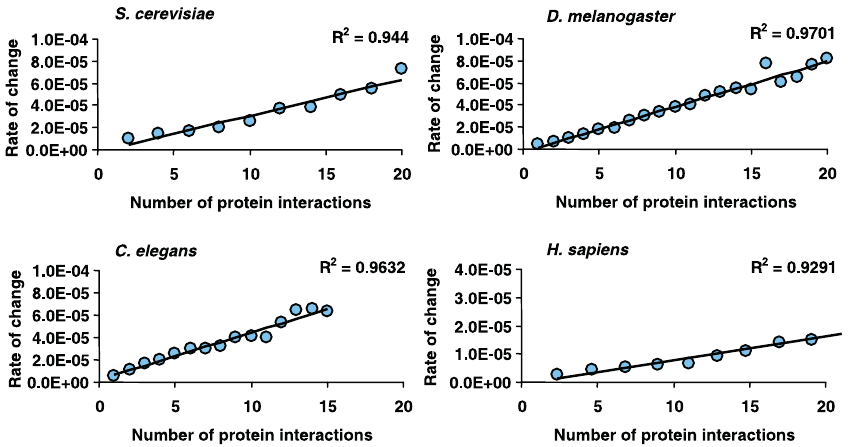
Figure 1. Preferential Interaction Turnover Is Observed in All Eukaryotic Interactomes We have binned proteins according to their average number of interactions and calculated for each bin the rate of change of interactions. There is a very strong correlation between the degree of connectivity and the interaction turnover.